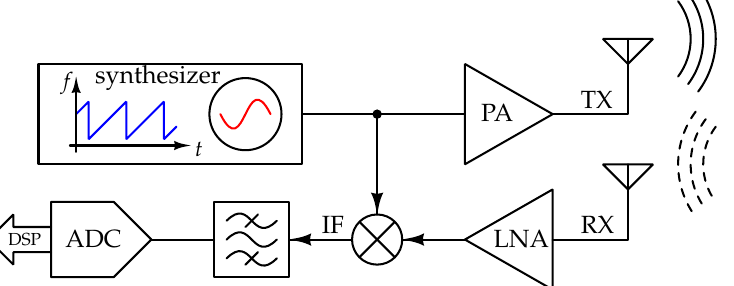
Figure 2. A simplified high-level block diagram of a typical single-input single-output (SISO) homodyne FMCW radar, which includes a linear chirp synthesizer that is being transmitted and used as the local